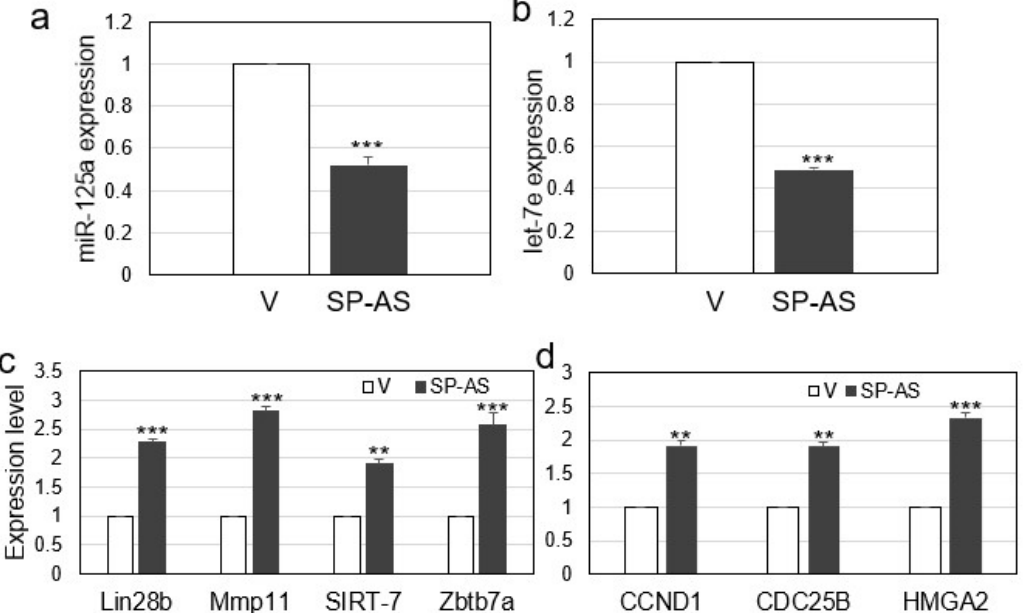
Figure 4. Effect of SP-AS overexpression on miR-125a and let-7e expression and their silencing activity. ( a ) miR-125a and ( b ) let-7e expression was evaluated after transfection of the SP-AS overexpressing vector (SP-AS) or the parental vector (V). ( c , d ) In the same transfection points of ( a ) and ( b ), the expression of the main targets of miR-125a and let-7e was evaluated. Data are reported as mean ± s.d. of replicate analyses. ** p < 0.01, *** p < 0.001 at Student’s t -test.